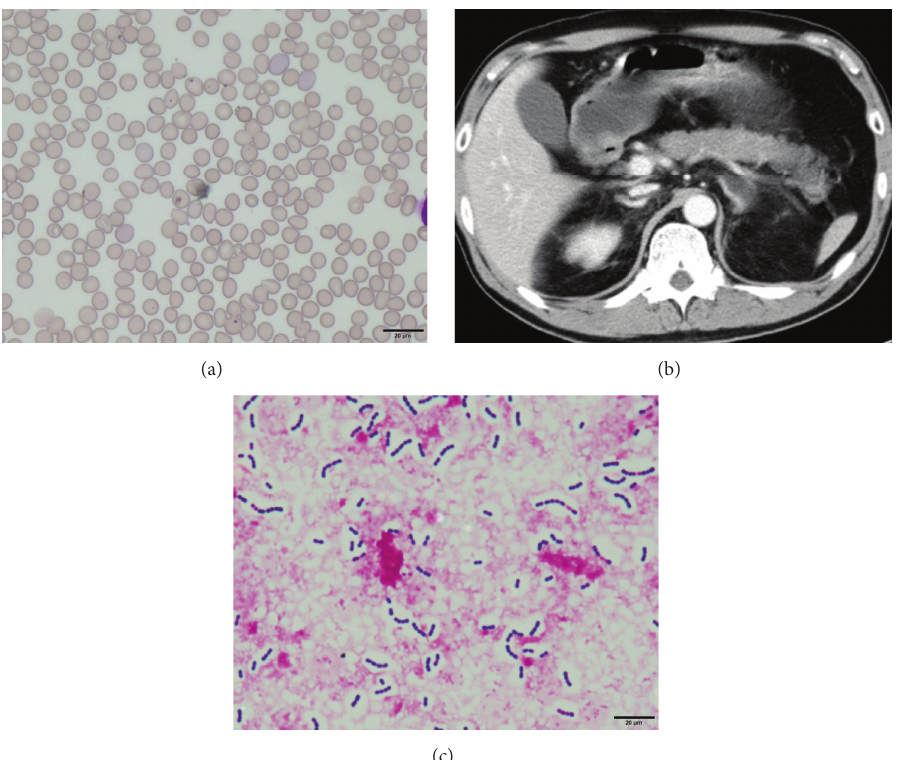
Figure 1: Peripheral blood smear, CT, and blood culture. (a) Peripheral blood smear revealed Howell-Jolly bodies. (b) Contrast CT demonstrated a hypoplastic spleen and retrospective fat tissue stranding around the left adrenal gland. (c) A blood culture revealed streptococci with